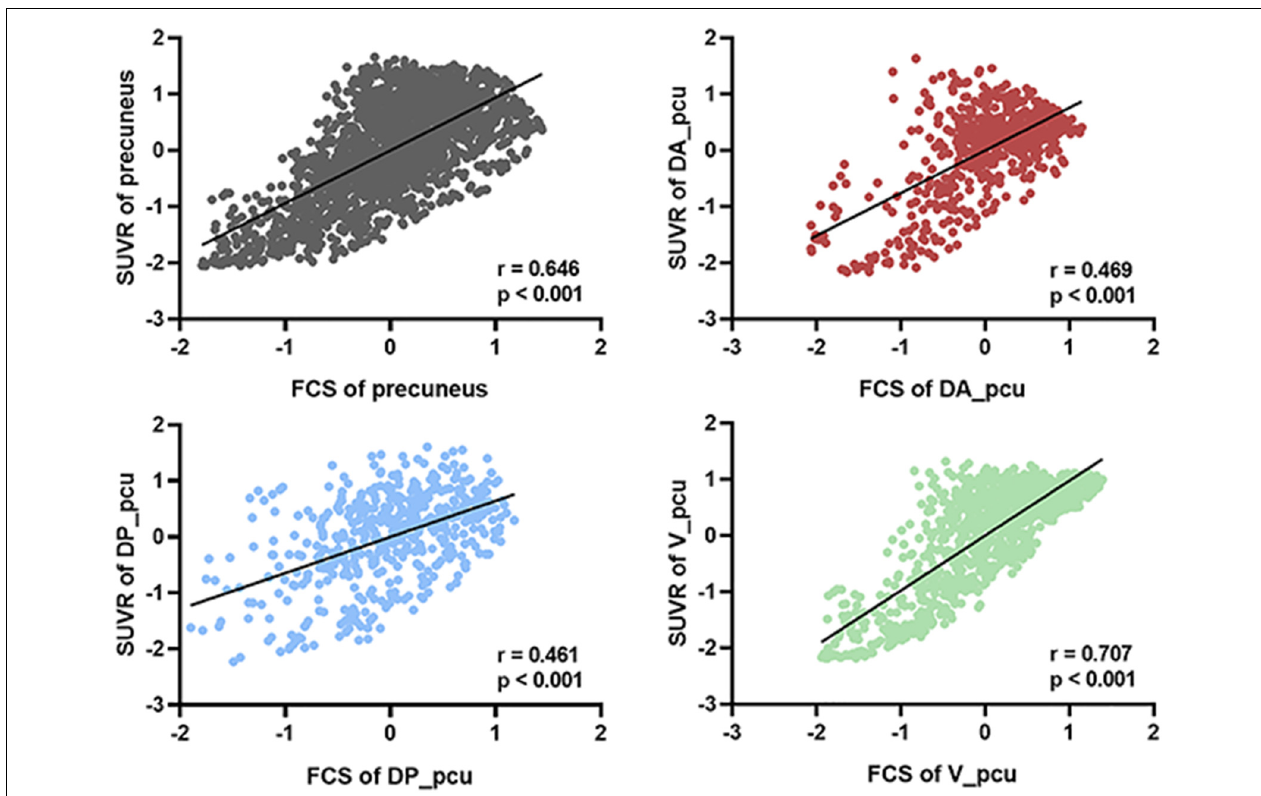
FIGURE 3 | Voxel-based correlations between FCS and SUVR in the whole precuneus and its subregions. V_pcu (green) had the highest functional-metabolic correlation compared to the precuneus and other subregions. For each voxel, standardized z-scores of both FCS and SUVR were averaged across all subjects ( N = 70). Spearmen’s correlation was performed between the two metrics across the voxels of the precuneus and each subregion. Abbreviations: FSC, functional connectivity strength; SUVR, standard uptake value ratio; V_pcu, ventral